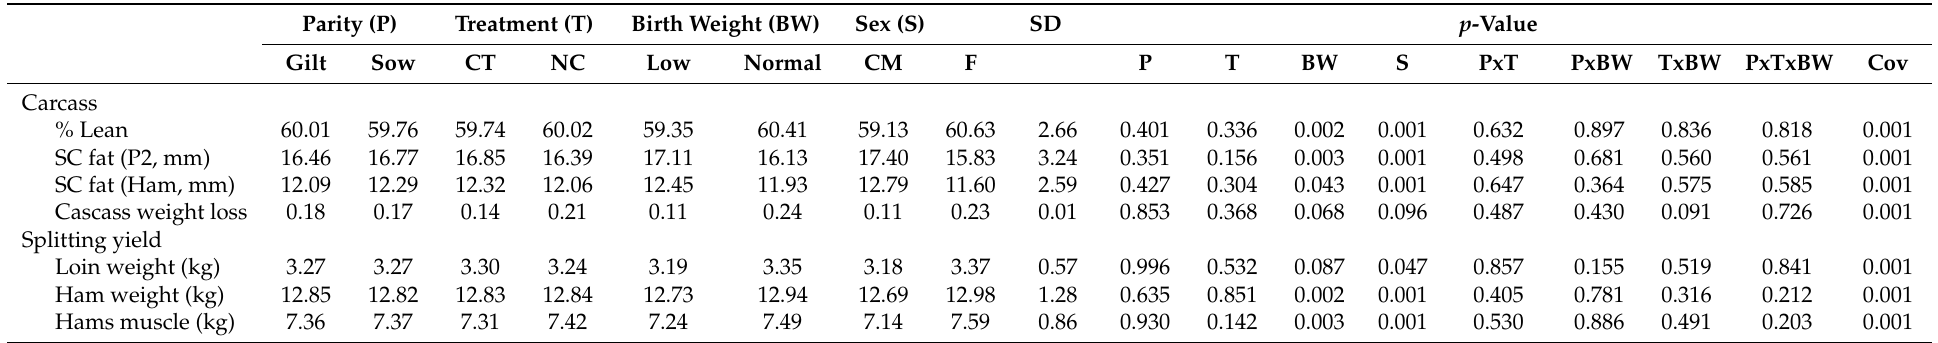
Table 3. Effect of parity (P), neonatal care treatment (T), birth weight (BW), and sex (S) on carcass characteristics and splitting yield (covariable carcass weight)